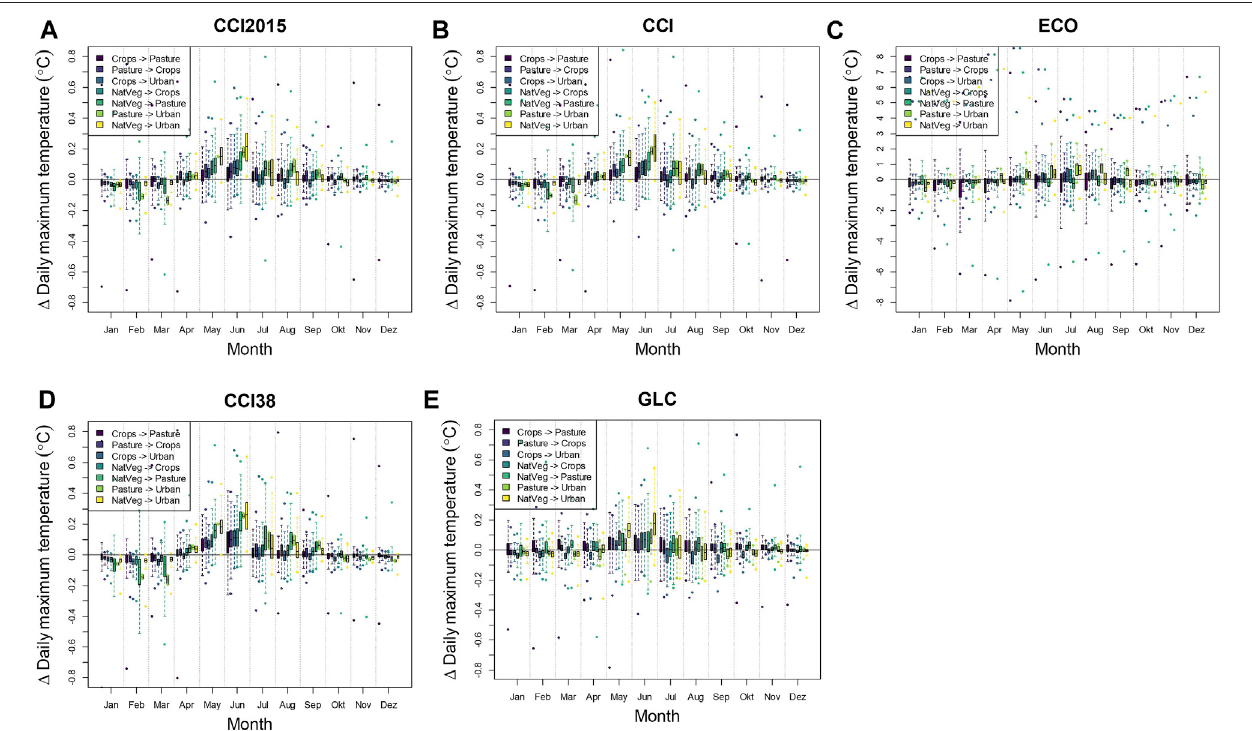
FIGURE10| Monthlydifferencesindailymaximumtemperatureduetodominantlandcoverchanges(morethan40%)betweenCCI2015andGC (A) ,CCIandGC (B) ,ECO andGC (C) ,CCI38and GC (D) ,andGLCandGC (E) forthetime period from2002to2011.Croplandgrid cellschangeintopasturetype (purple),pasturegrid cells change into crops (dark blue), crop grid cells change into urban type (blue), natural vegetation grid cells change into crop type (dark green), natural vegetation grid cells change into pasture type (green), pasture grid cells change into urban type (light green), and natural vegetation grid cells change into urban type (yellow). Differences are calculated for grid cells, where the listed land cover type change occurs. Please see Table 1 for abbreviations of simulation experiments.